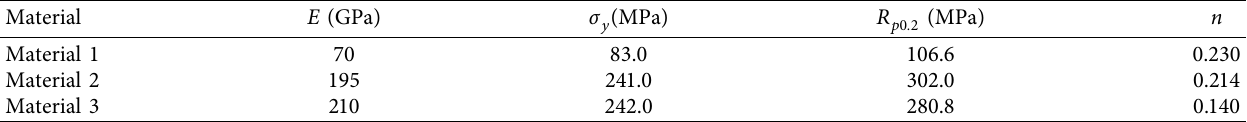
Table 2: Mechanical properties of 3 imaginary materials.